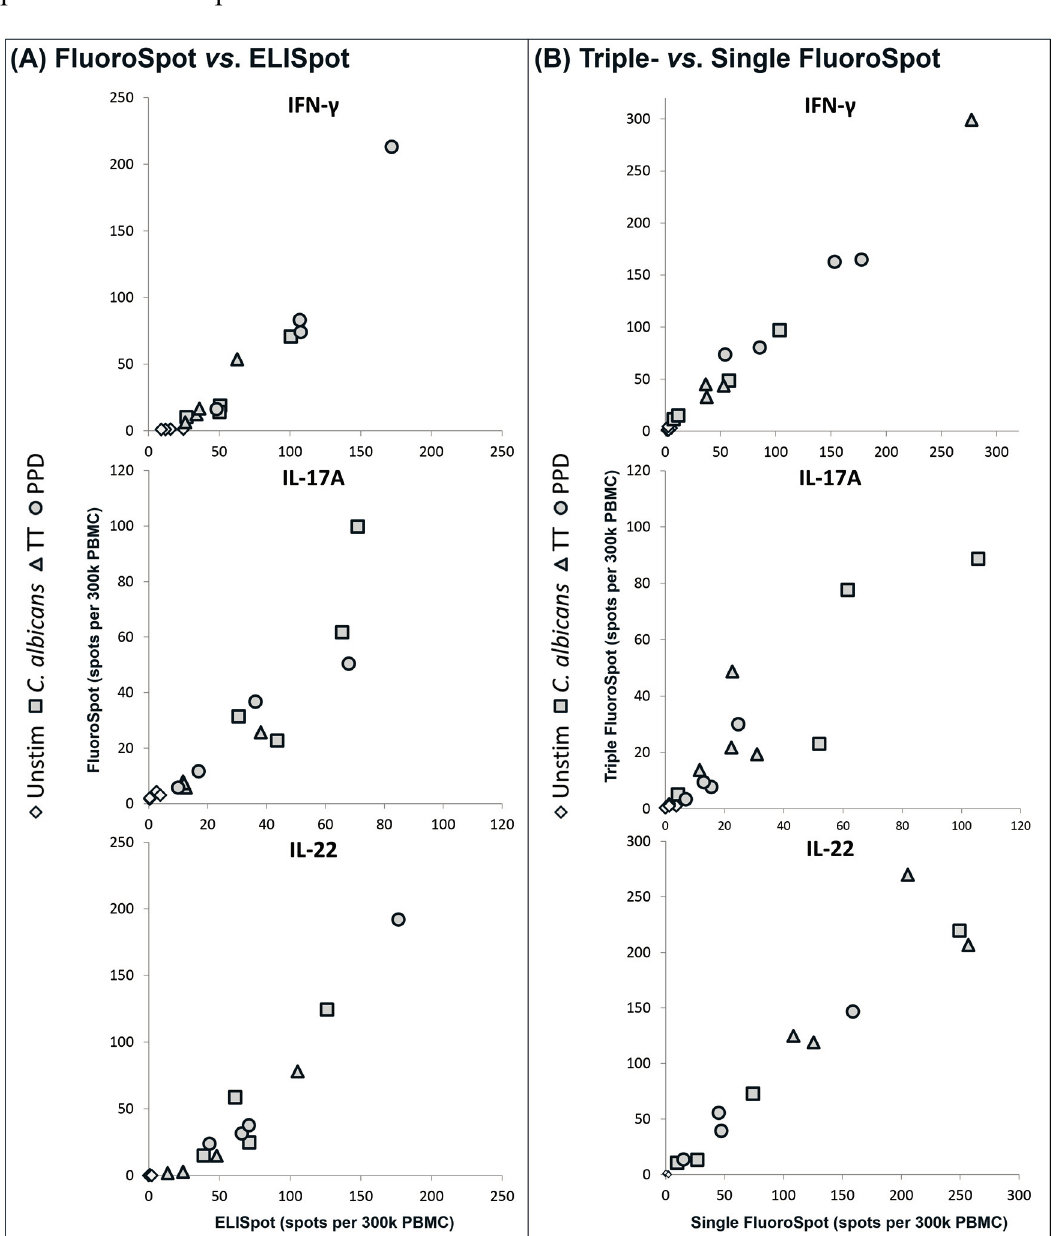
Figure 2. ( A ) Comparison of single cytokine FluoroSpot versus ELISpot. PBMC from four donors were stimulated with CA, TT or PPD or incubated with medium only and the number of cells secreting IFN- γ , IL-17A or IL-22 was determined by FluoroSpot and ELISpot; ( B ) Comparison of triple versus single cytokine FluoroSpot. PBMC from four other donors than in (A) were cultured as in (A) and analyzed in triple and single FluoroSpot for the number of cells secreting IFN- γ , IL-17A or IL-22. To obtain comparable data, spots in the triple FluoroSpot were counted as single cytokine spots, i.e. , double and triple positive spots were counted as positive for each cytokine. The symbols in (A) and (B) represent the mean of triplicates with different symbols corresponding to unstimulated or antigen-stimulated PBMC. The variation within triplicates for the antigen-stimulated wells was on average 25%. All comparisons in (A) and (B) correlated positively (r s = 0.92–0.98 and p < 0.0001). The experiments were repeated with PBMC from additional donors with similar